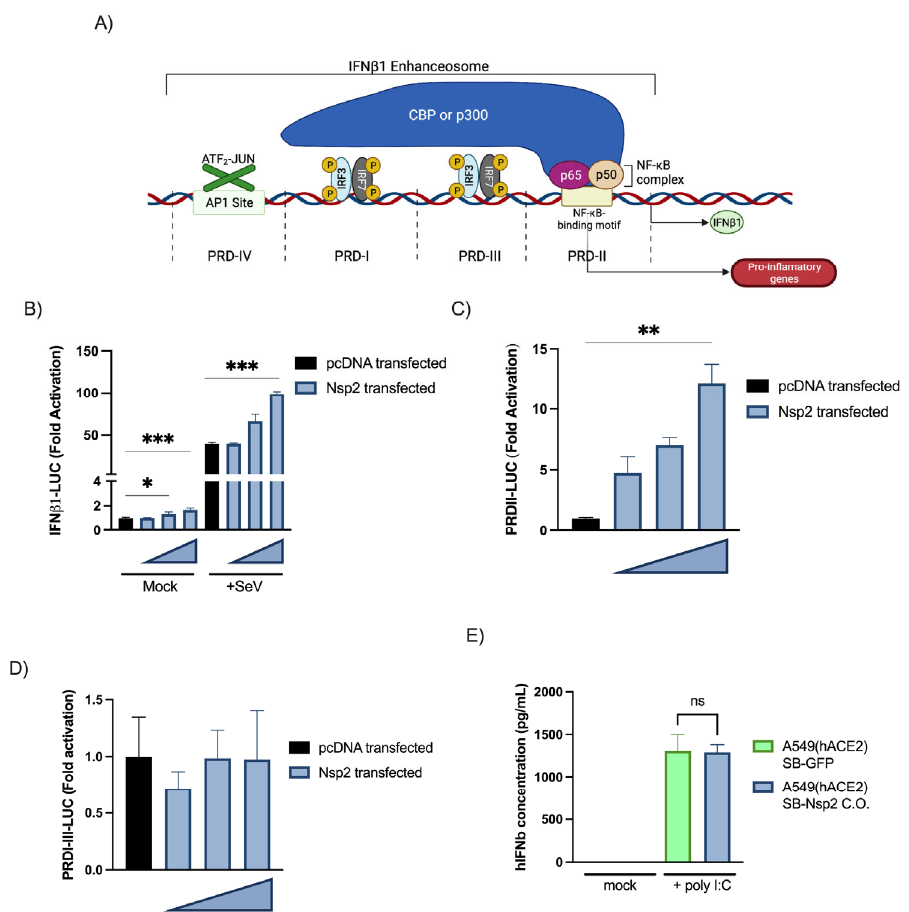
Figure 4. Characterization of IFN β promoter activation by Nsp2(C-E). Overview of the IFN β pro- moter ( A ). Impact of Nsp2 expression on the IFN β promoter ( B ), the NF- κ B responsive elements, positive regulatory domain II (PRDII) ( C ) and IRF3-responsive elements, the positive regulatory do- mains I and III (PRDI-III) ( D ) of those promoters. Reporter essays were performed as described above with 300 ng, 200 ng, and 100 ng of vector encoding for Nsp2. All experiments were performed twice in triplicate, and one representative experiment is shown. Results are expressed as fold activation relative to the pcDNA mock-infected control (mean ± SD, n = 3 replicates/condition). Effect of Nsp2 expression on the IFN β 1 production ( E ). Twenty-four hours post-seeding, A549-hACE2 SB-Nsp2 or SB-GFP cells were induced with 0.5 µ g/mL of Doxycycline. Thirty-two hours post-induction, cells were stimulated with poly(I:C) for sixteen hours and IFN β 1 was measured in the supernatant by ELISA. All experiments were performed twice in triplicate and the compilation of the data is shown. Results are expressed as activation percentage relative to the poly I:C mock-infected con- trol (mean ± SD ( n = 6 replicates/condition)). Statistical analyses were performed by comparing corresponding condition with mock-transfected control with a nonparametric one-way ANOVA with Dunn’s correction. ns: not significant, * p < 0.05, ** p < 0.01, *** p < 0.001.